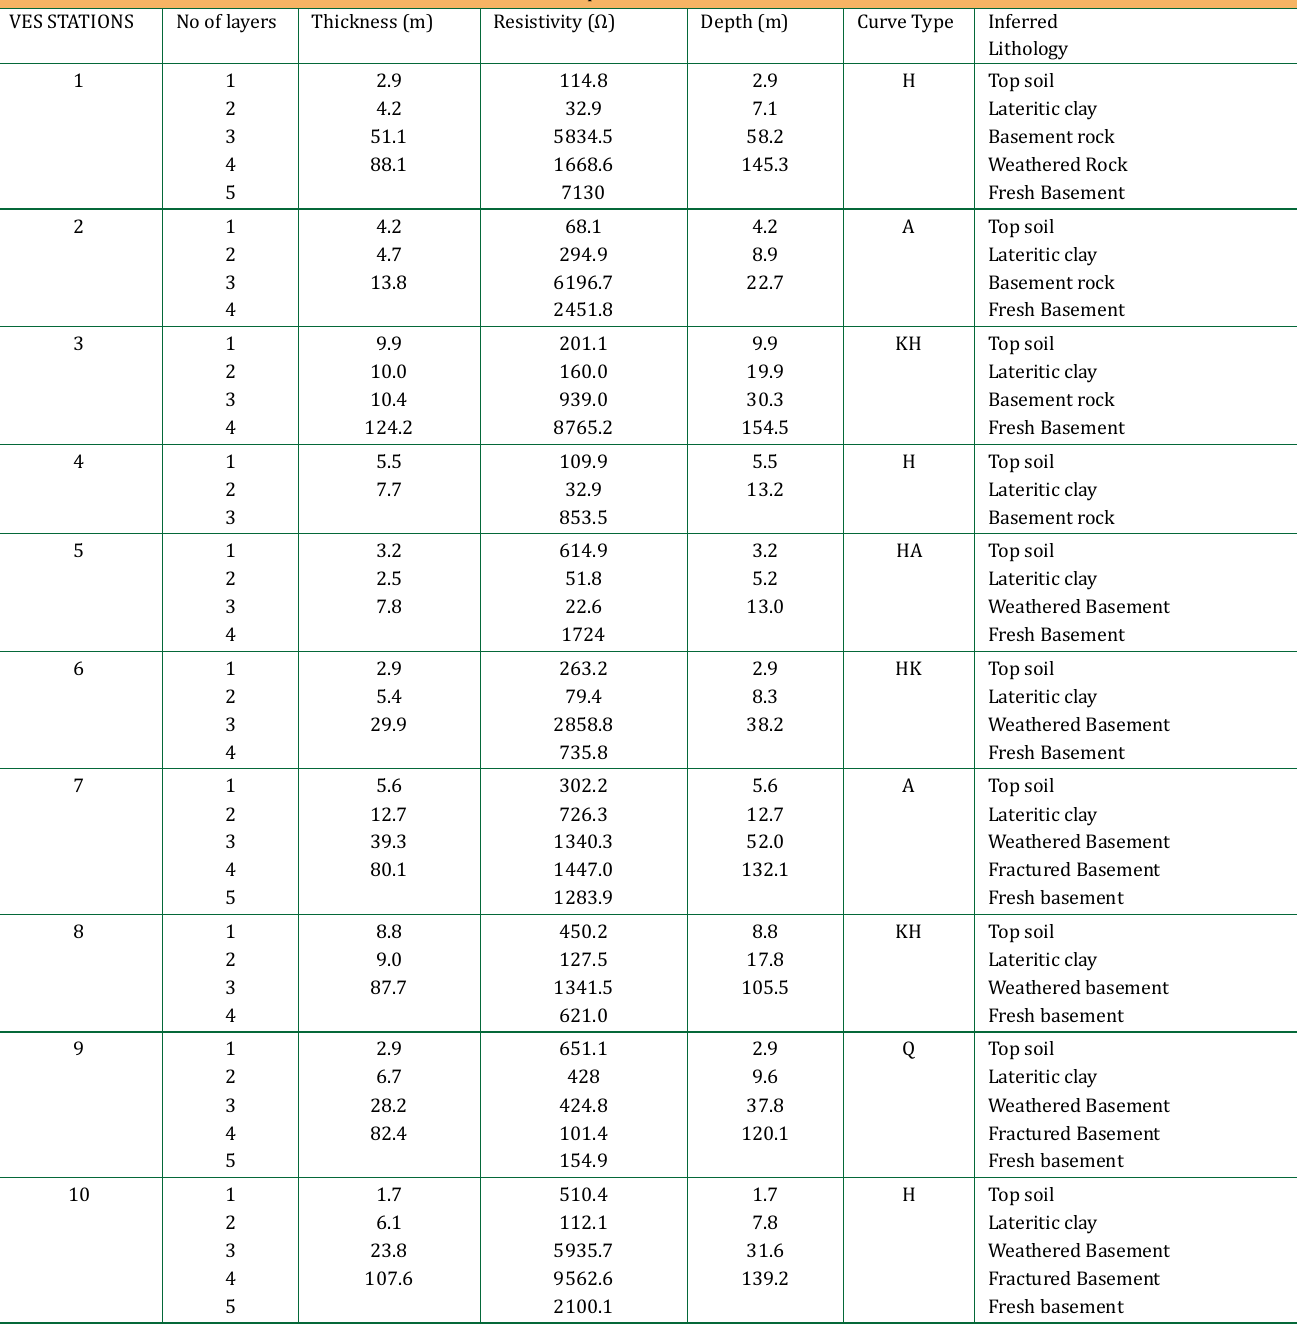
Table 1: The Interpretation of VES 1 to 10